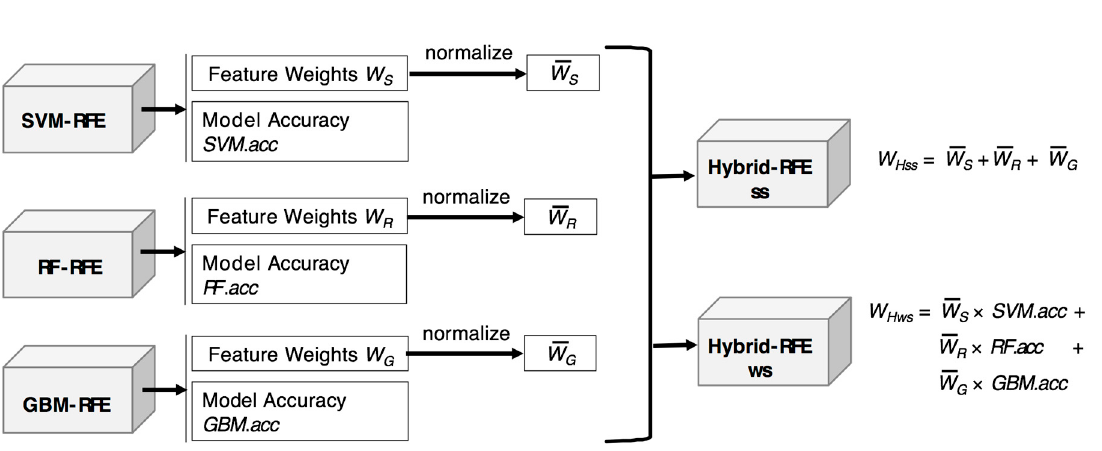
Figure 2. Two types of weighting functions of Hybrid-RFE.